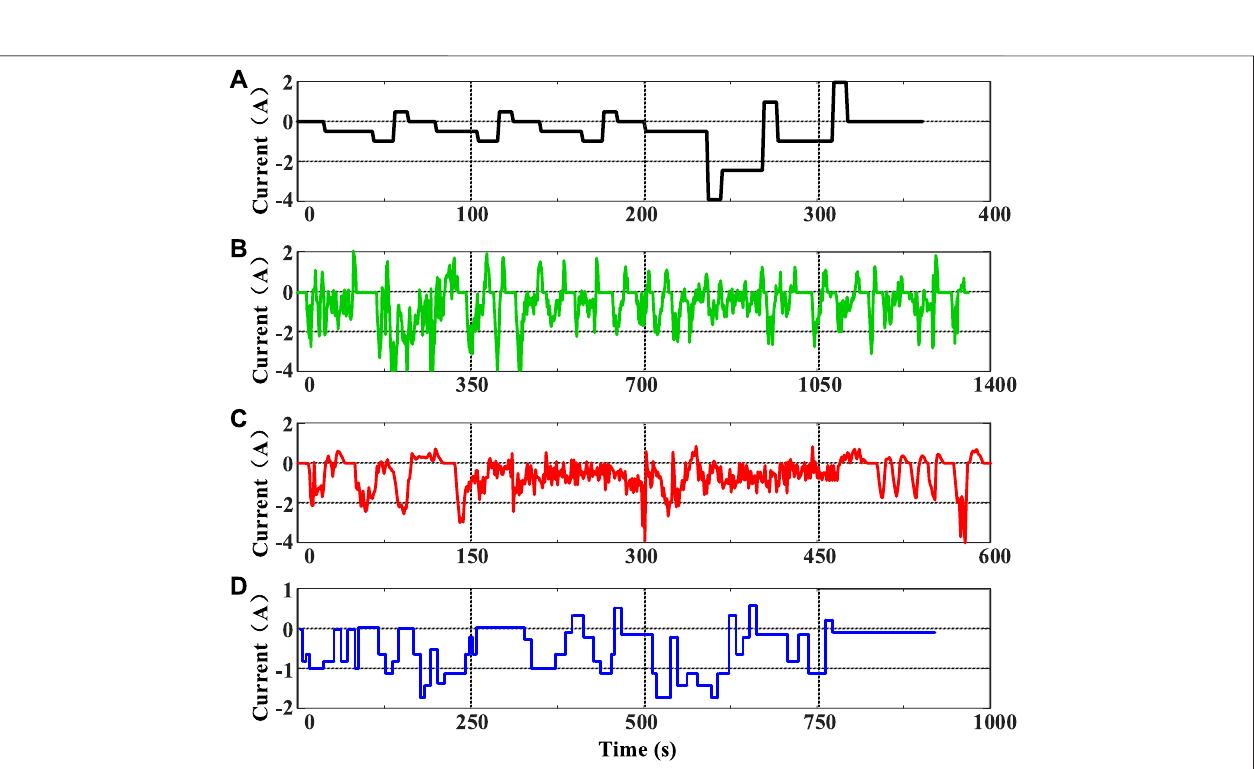
miles, and average speed = 19.59 mph. For US06 driving schedules, duration = 596 s, distance = 8.01 miles, and average speed = 48.37 mph. For LA92 driving schedules, duration = 1,435 s, distance = 9.82 miles, and average speed = 24.61 mph.